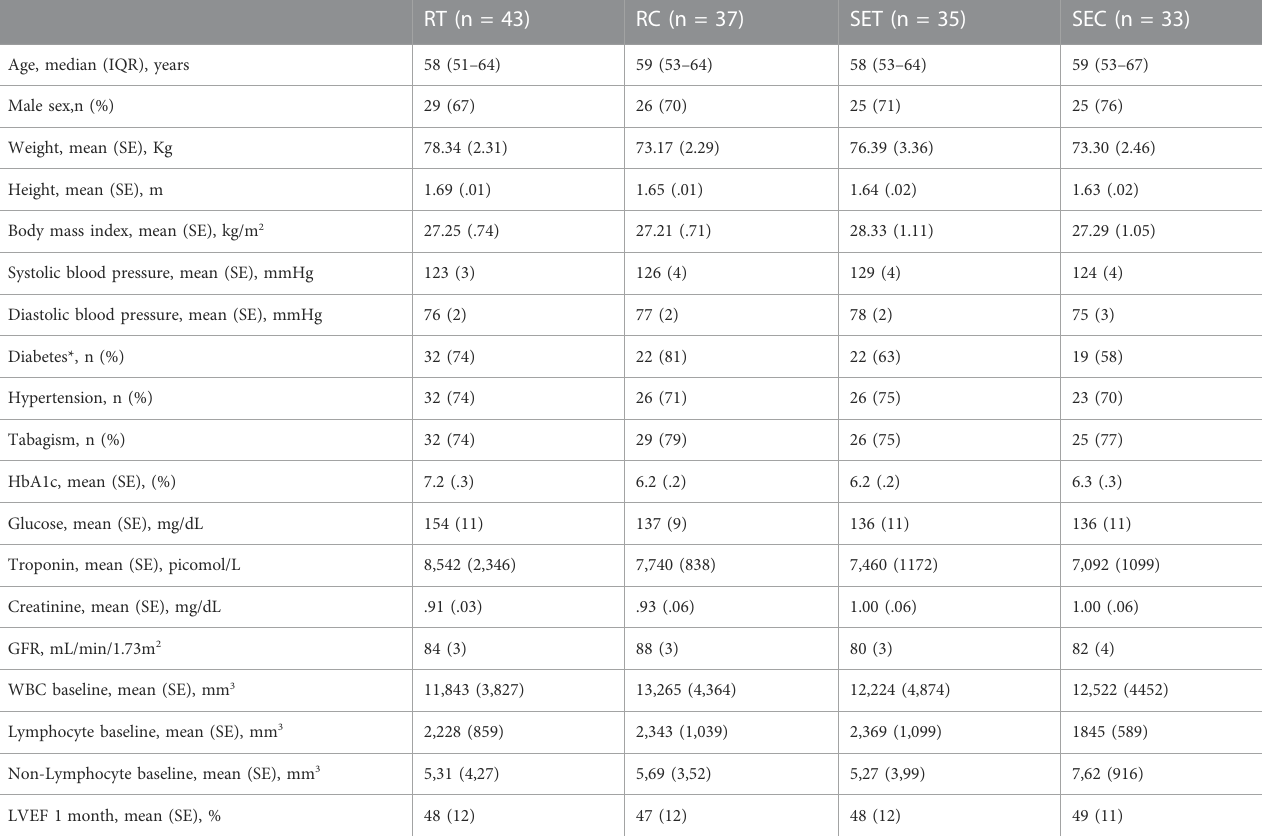
TABLE 1 General characteristics from the participants of the